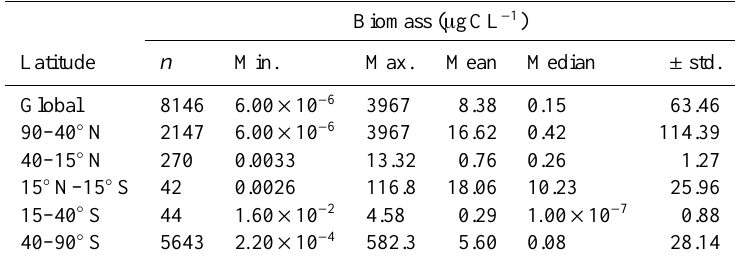
Table 3b. Global and latitudinal band values for the gridded macrozooplankton biomass